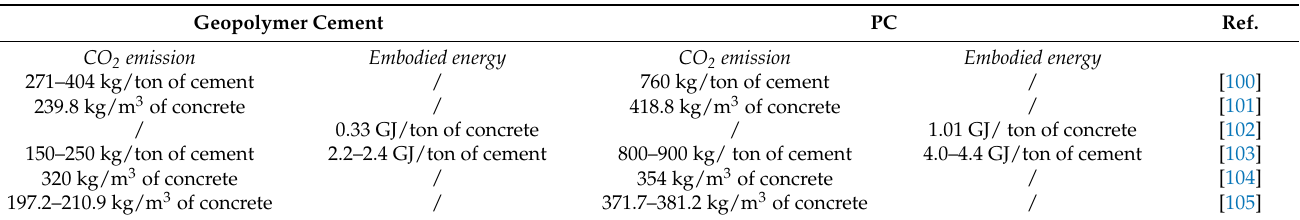
Table 7. Overview of LCA literature data on the carbon footprint and embodied energy involve in geopolymer and PC production. Geopolymer